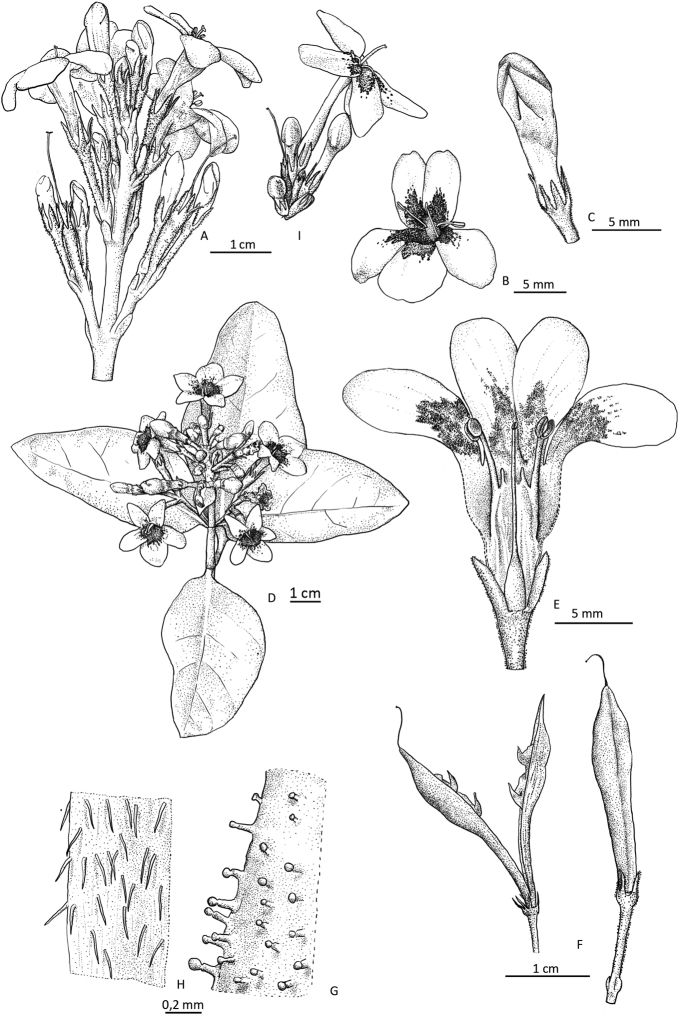
Drawings of Pseuderanthemum
melanesicum Gâteblé, Ramon & Butaud, sp. nov. and P.
carruthersiiA–GPseuderanthemum
melanesicumH–IPseuderanthemum
carruthersiiA, D Structure of the inflorescence B Flower C Flower bud E Open corolla with the lower corolla lobe removed to show the arrangement of internal structures F Open mature and immature capsules G Glandular hairs on a flower bract H Eglandular hairs on the outer surface of the corolla tube I Part of inflorescence showing the long narrow tube of a flower. Voucher specimens: A–DGâteblé 1072E, GGâteblé 722FRamon 220H–IGâteblé 720. Drawings by Laurence Ramon.